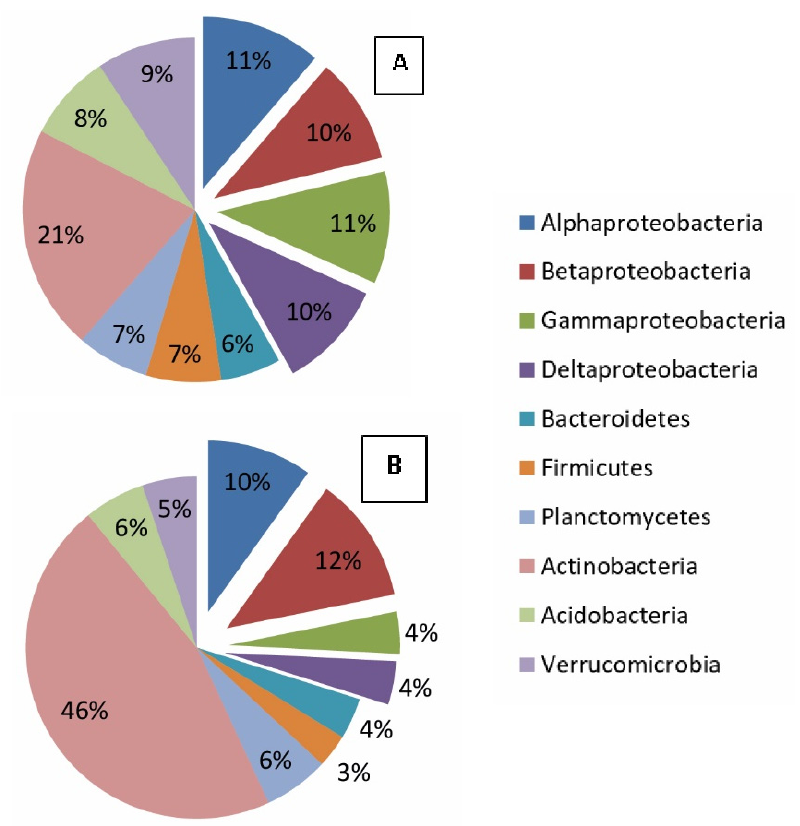
Figure 7. Structure of the metabolically active bacterial complex of the buried horizon of stratified ochre soil on the 10th day of succession with the addition of substrates: ( A )—control; ( B )—chitin.